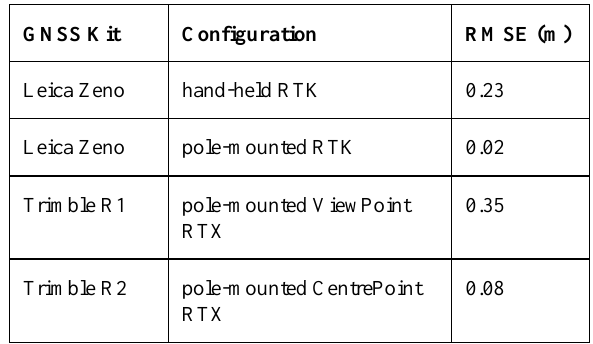
Figure 1. A coloured point cloud of a building in Eastleigh, captured using the MX8 mobile mapping